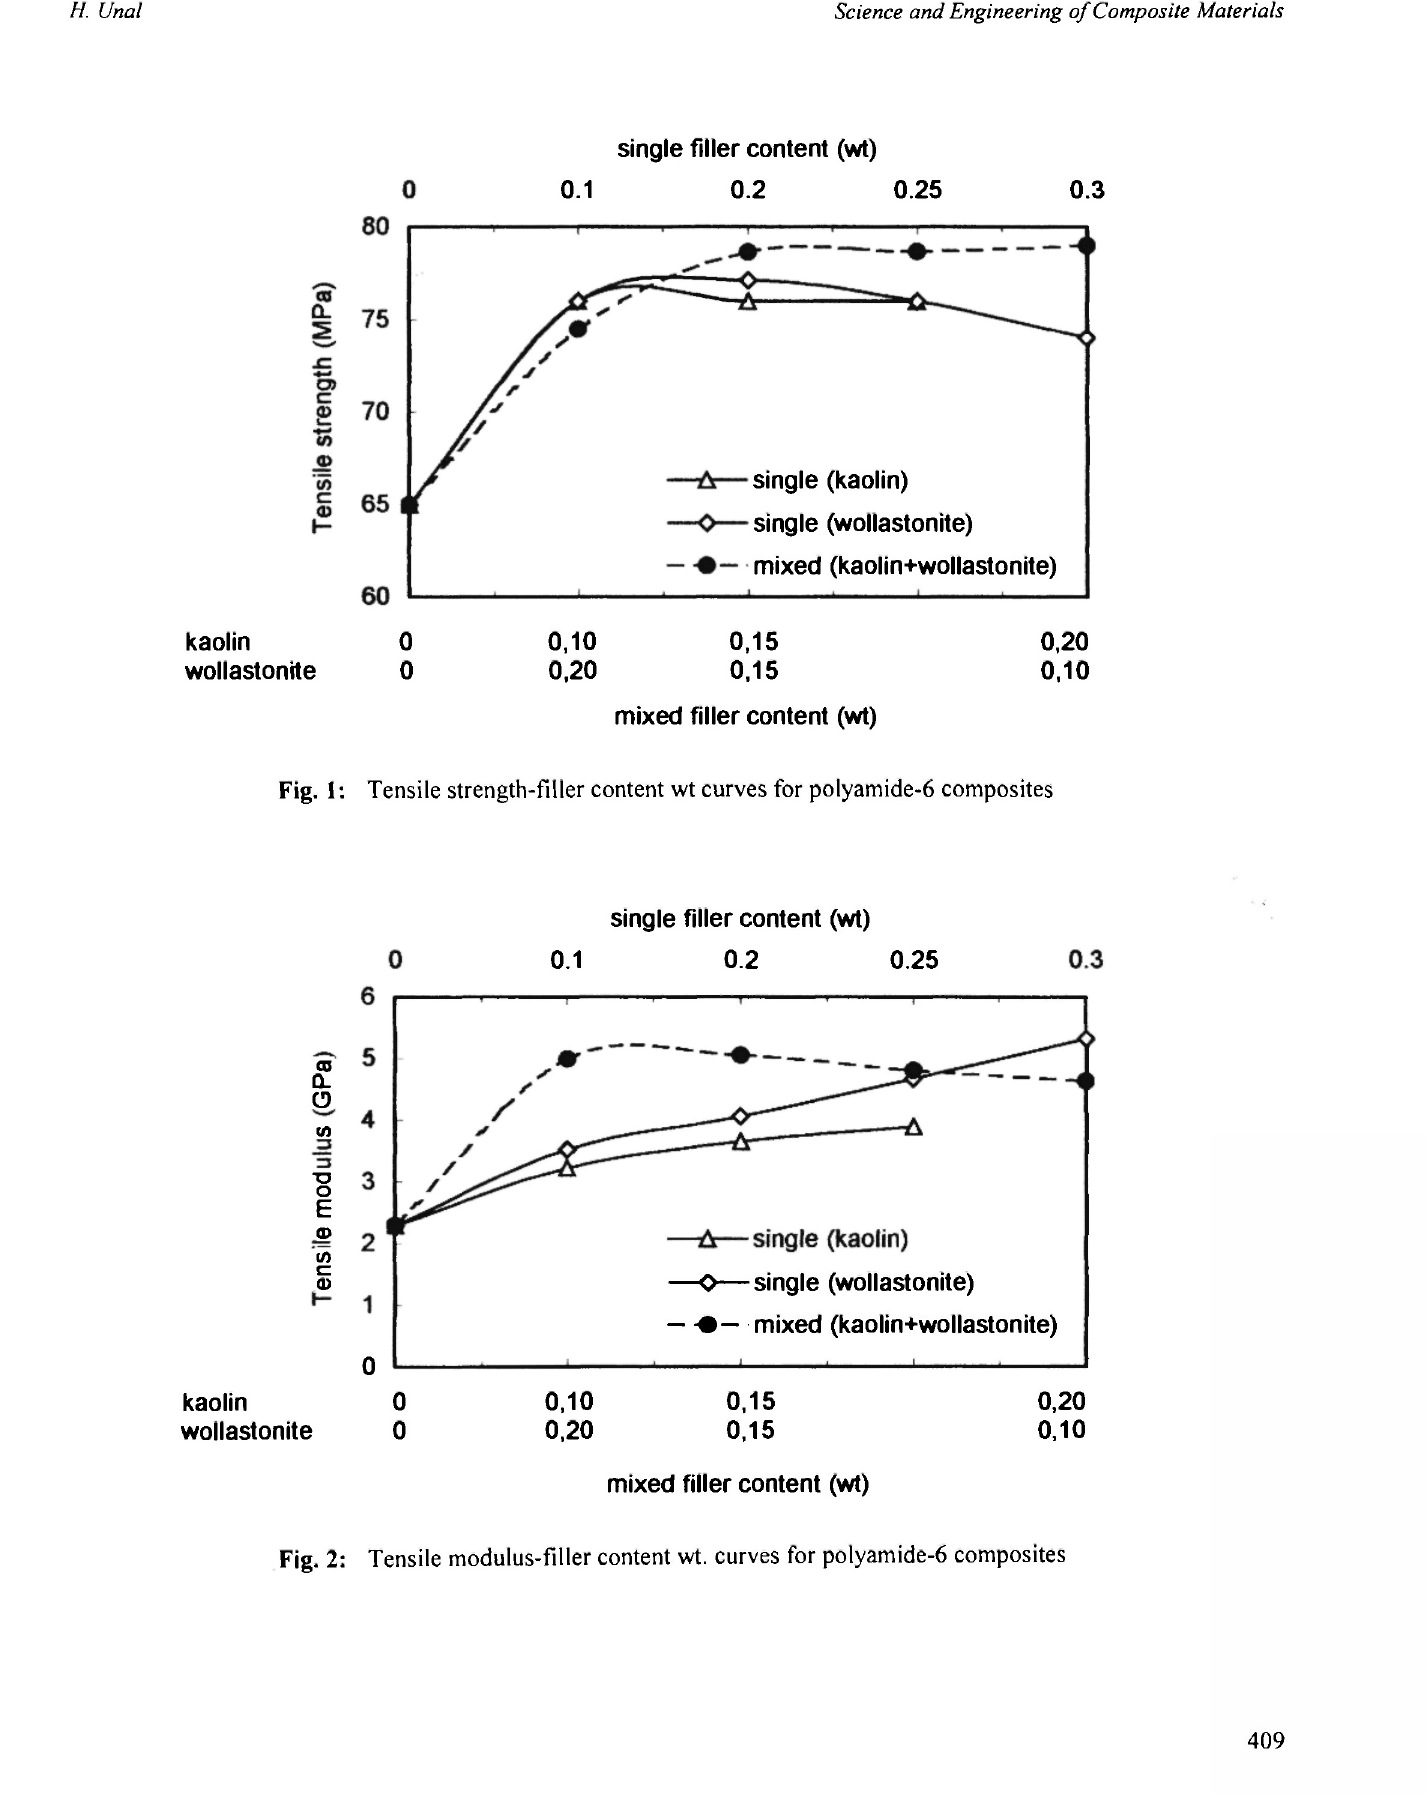
Fig. 2: Tensile modulus-filler content wt. curves for polyamide-6